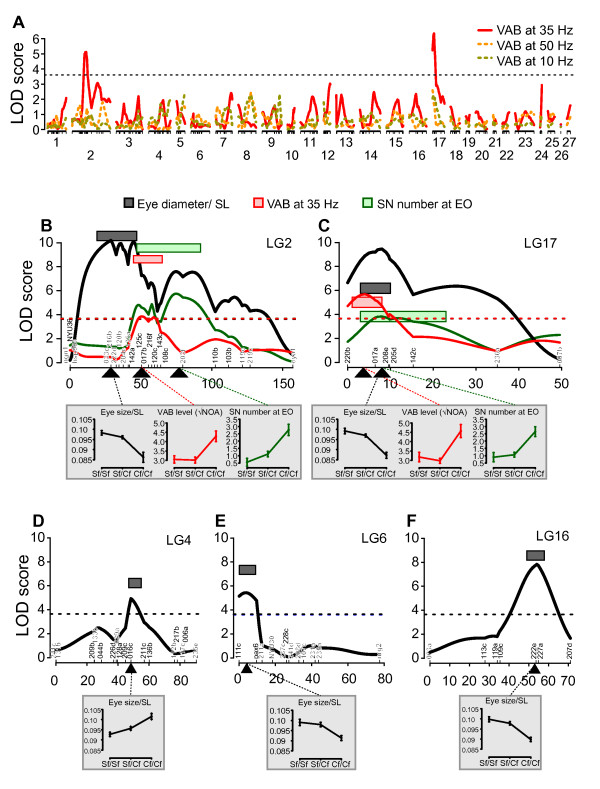
QTL mapping of VAB, SN number and size, and eye size. (A) LOD scores computed with single-QTL model genome-scan are plotted against the distance across each linkage group (LG). Red solid lines indicate LOD scores for VAB-level at 35 Hz vibration stimulus, yellow dotted lines for VAB at 50 Hz stimulus, and lime green dotted lines for VAB at 10 Hz stimulus. Significant VAB QTL were detected at LG2 and 17 only at 35 Hz stimulus. The horizontal line indicates the genome-wide significance thresholds at P < 0.05. (B, C) LOD scores computed following multiple QTL mapping. Nine QTL were found across five different LG (see also Table 1). Six overlapping Bayesian credible intervals of QTL for VAB, EO SN number and eye size were found on LG 2 and 17. The X-axis indicates genetic distance in centimorgans (cM), and colored bars denote Bayesian credible intervals with probability coverage as 0.95 for each significant QTL. Insets with gray background show effect plots of phenotypic values against each genotype (mean ± s.e.m.) at the peak locus denoted by the black triangle. Sf/Sf, surface fish homozygote, Sf/Cf, heterozygote, and Cf/Cf, cavefish homozygote. Horizontal dotted lines are genome-wide significant thresholds (P < 0.05) calculated from the single-QTL model (see Methods).